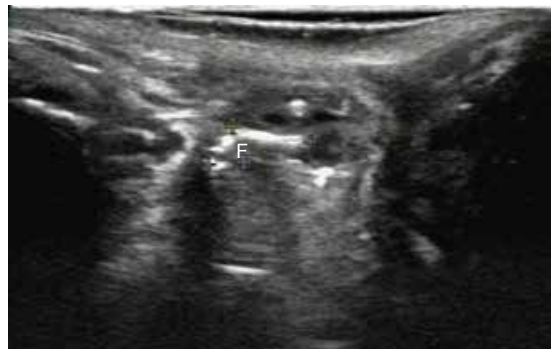
Figure 3 Transperineal sonographic image of a 9 × 4 mm foreign body in the vagina of a 6-year-old girl. Ultrasonic examination revealed a thickening of the vaginal wall and a small amount of anechoic liquid. F, foreign body.